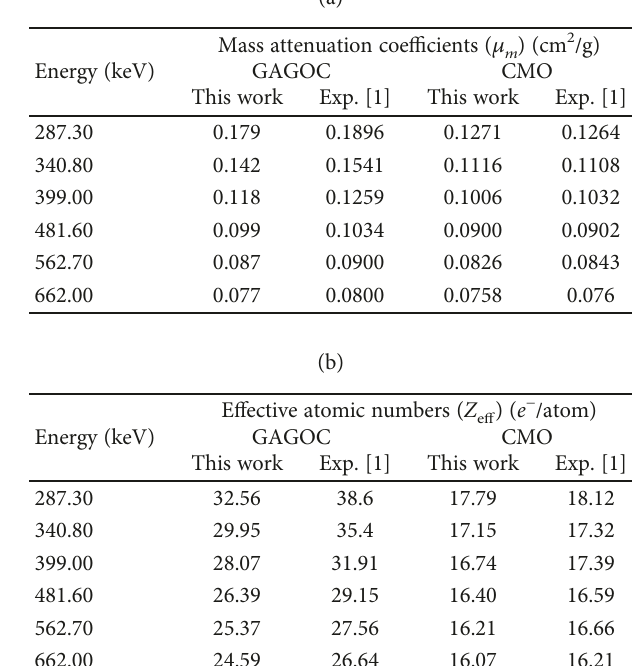
Table 3: Theoretically and experimentally obtained values of mass attenuation coe ffi cients and e ff ective atomic numbers of the GAGOC and CMO scintillator materials.